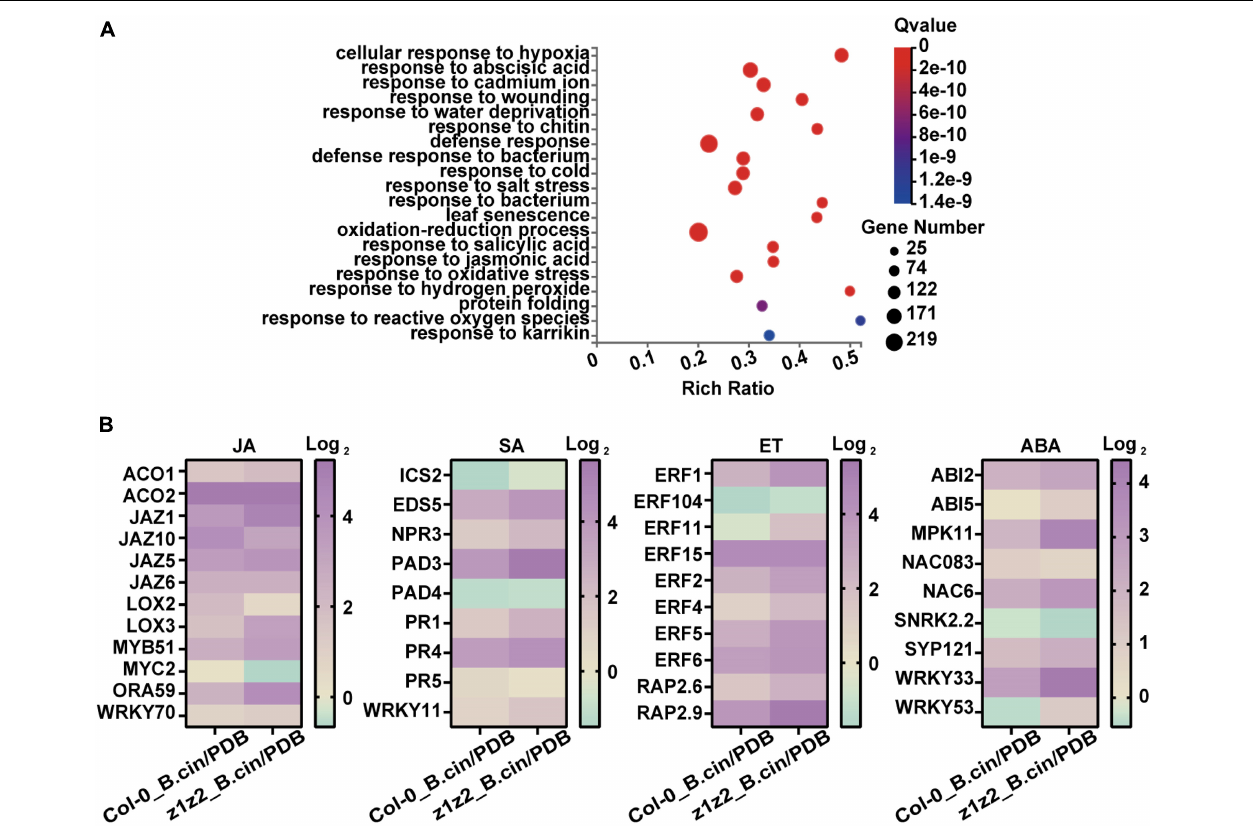
FIGURE 7 | Analysis of differentially expressed genes involved in defense-related hormone pathways in zar1-3 zar2-1 and Col-0 plants upon B. cinerea infection. (A) Top 20 GO enrichment of the genes detected in the transcriptomes that have significant differences in Col-0 plants ( B. cinerea treatment) and zar1-3zar2 plants ( B. cinerea treatment). (B) Expression profiles of various JA, SA, ET, and ABA-related genes in Col-0 and zar1-3zar2-1 double mutant compared between different treatment conditions (Col-0_ B.cin/PDB: Col-0 samples treated with B. cinerea compared with Col-0 samples treated with PDB, z1z2_B.cin/PDB: zar1-3zar2-1 double mutant samples treated with B. cinerea compared with zar1-3zar2-1 double mutant samples treated with PDB). Heatmap showed TPM levels of DEG genes from